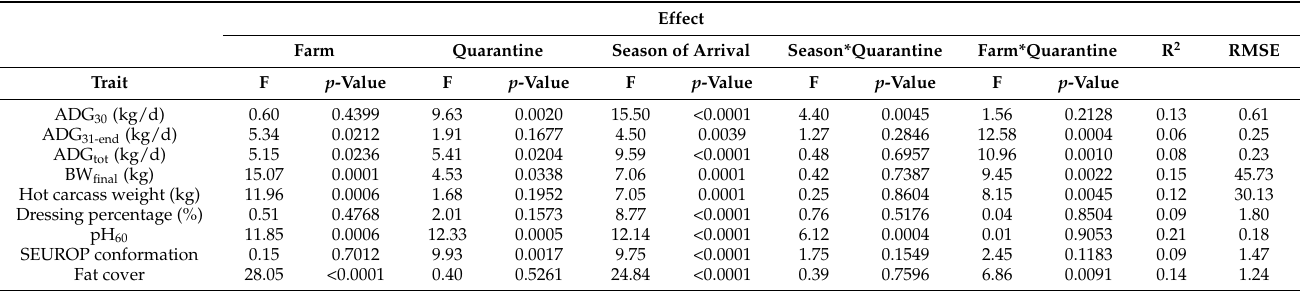
Table 1. Significance of the effects included in the ANOVA of growth and post-mortem performances 1 of Charolaise young bulls ( n =